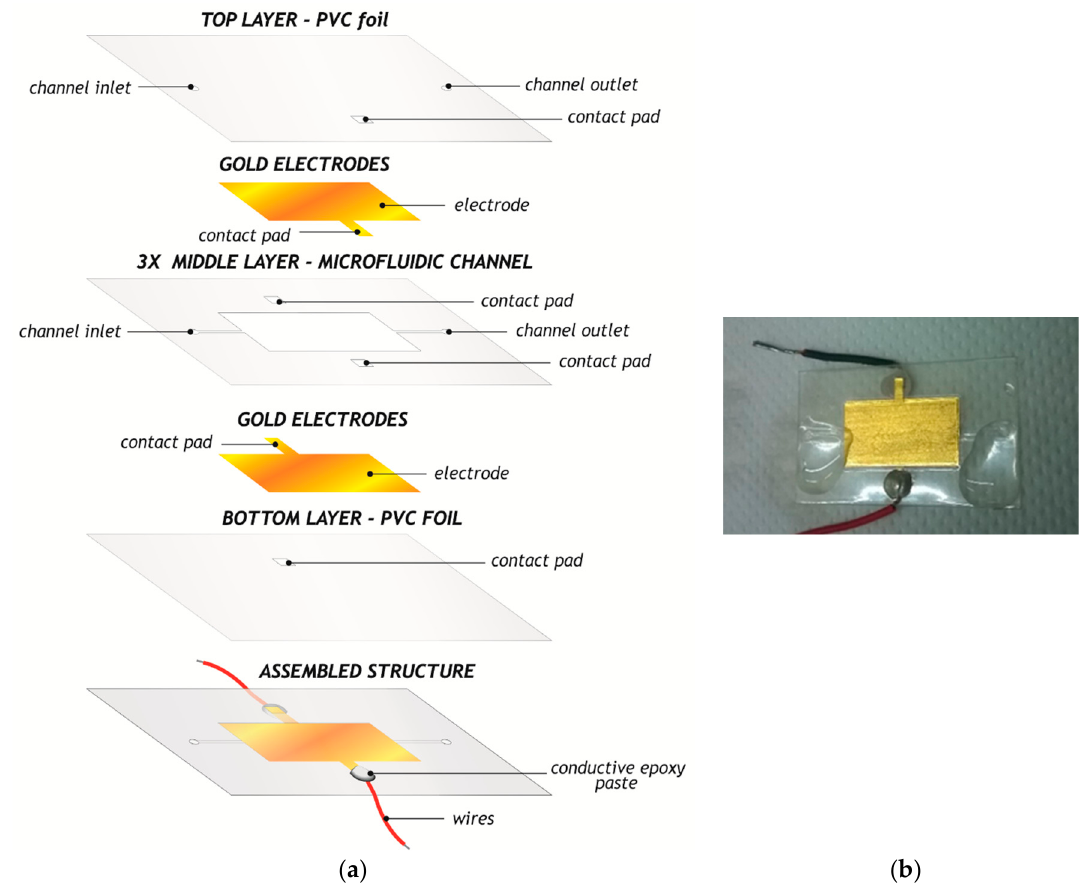
Figure 6. ( a ) Design of all layers of the capacitive structure: PVC layer with two gold electrodes of the capacitor, middle layer—microfluidic channel, top layer—for inlet, outlet and electrical terminals, ( b ) fabricated microfluidic capacitor with fluid inside the channel.